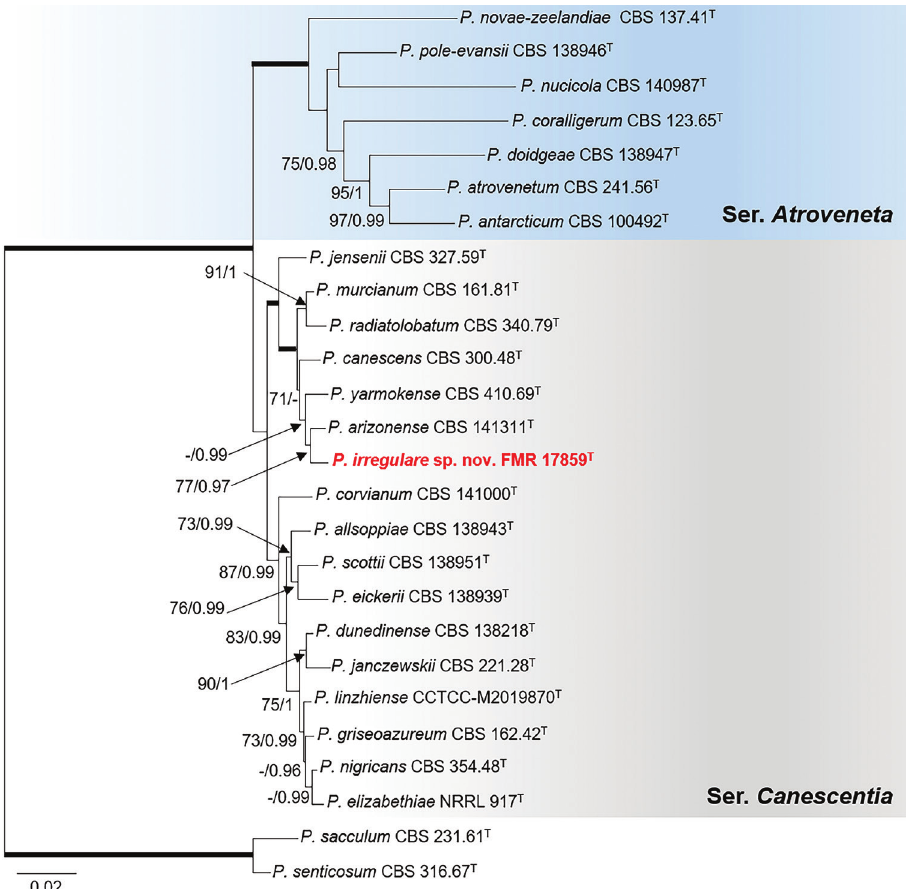
Figure 4. Phylogenetic tree of Penicillium section Canescentia based on ML analysis obtained by RAxML inferred from the combined tub 2, cmdA , ITS, and rpb 2 loci. Branch lengths are proportional to phylogenetic distance. Bootstrap support values/Bayesian posterior probability scores above 70%/0.95 are indicated on the nodes. Bold branches indicate bs/pp values 100/1. The tree is rooted to P. sacculum CBS 231.61 and P. senticosum CBS 316.67. The name in red is the new species described in this study. T = Ex-type